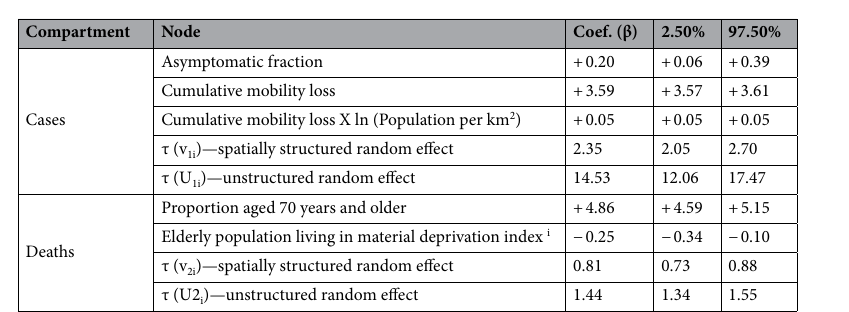
Table 1. Posterior statistics from the Bayesian multivariable space–time SEIR model using WinBUGS. i: increasing score indicate lower level of material